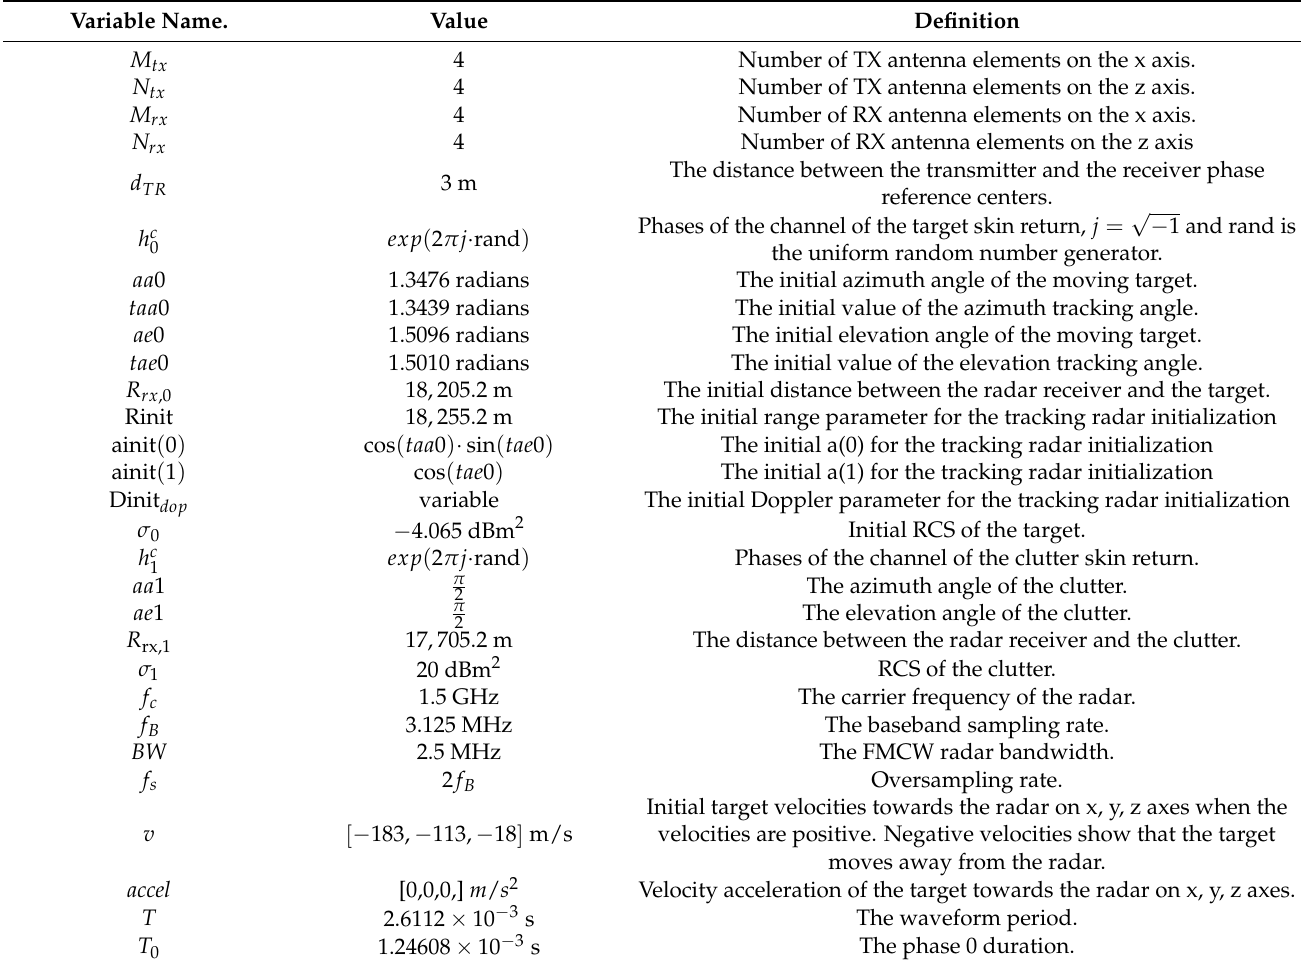
Table 2. The simulation